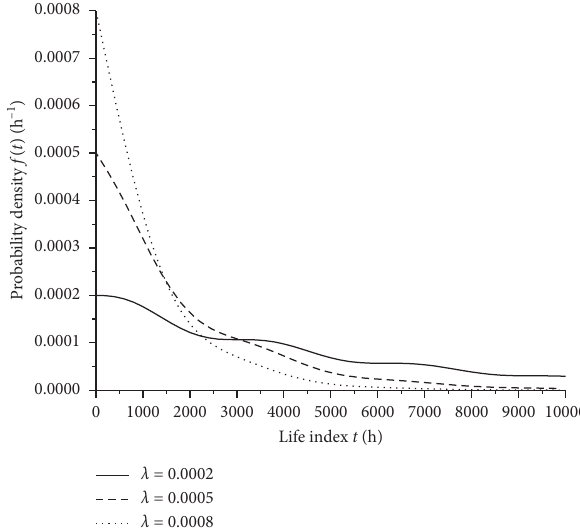
Figure 10: Effects of attenuation coefficient on probability density.